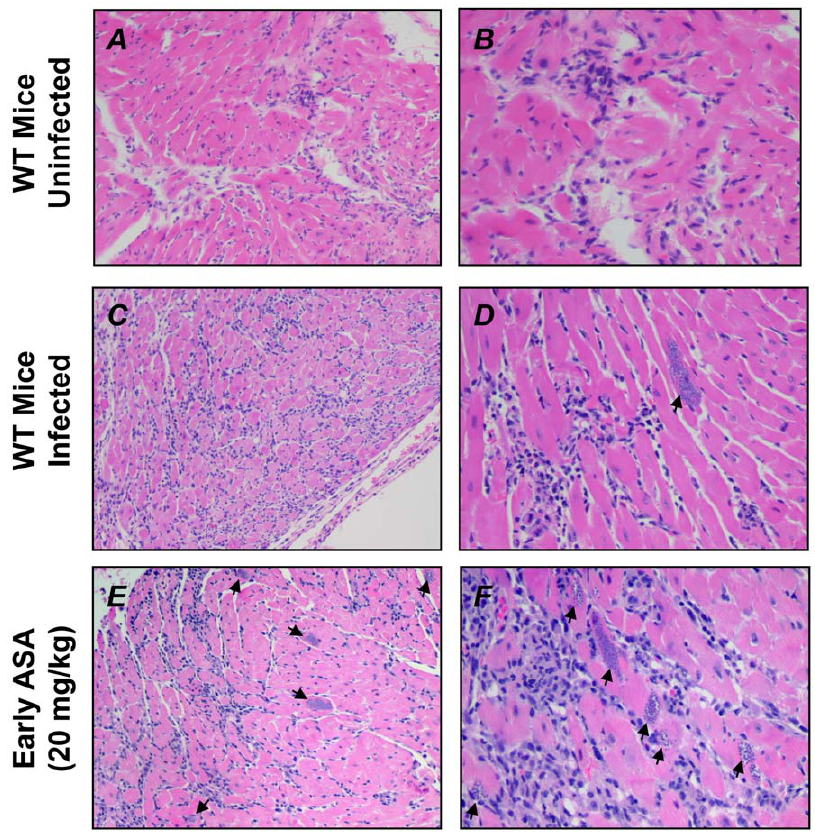
Figure 3. Cardiac pathology in ASA-treated mice is no different to vehicle treated control s . Representative histopathology of infected CD-1 mice with and without ASA treatment (20 mg/kg) at 35 dpi compared with uninfected controls. Sections were stained with H&E. Parasite pseudocysts are observed (arrows). Total magnification of either 100 6 ( A,C,E ) or 400 6 ( B,D,F ). Images are representative of al least five mice in each group.